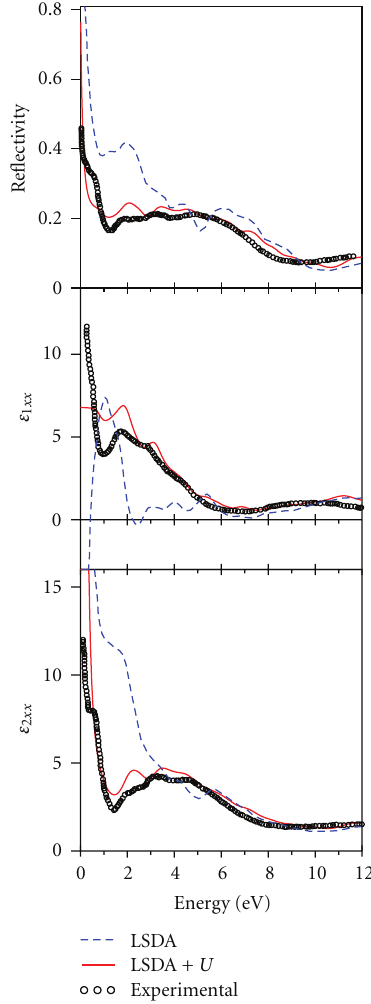
Figure 5: Optical reflectivity and diagonal parts of the dielectric function ε xx of Fe 3 O 4 calculated in the LSDA and LSDA+ U approx- imation [10] compared with experimental data [140] (open